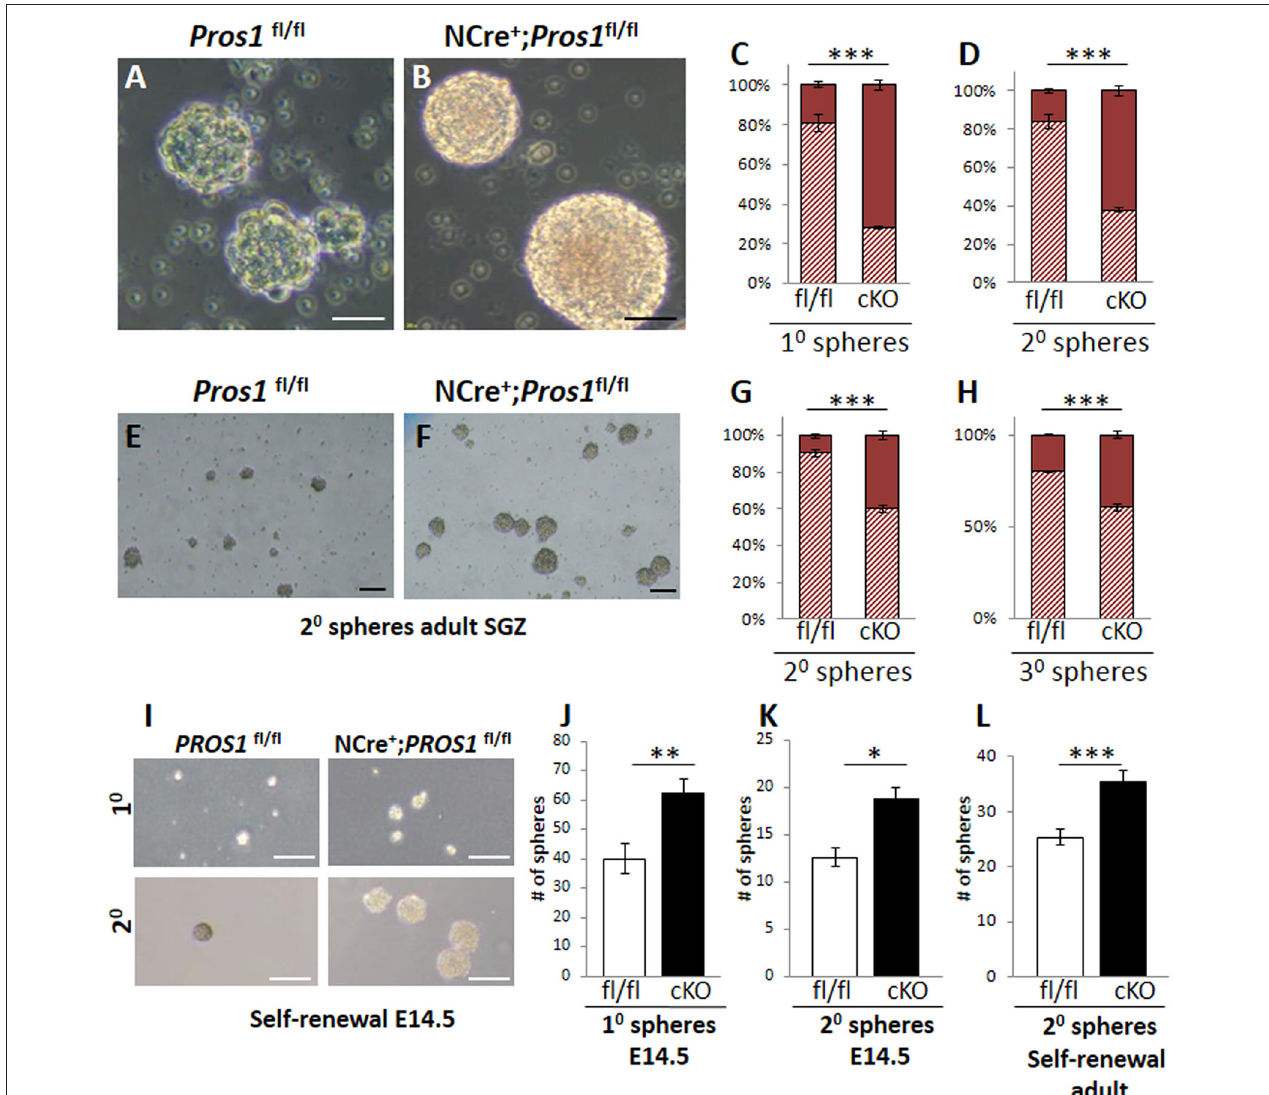
FIGURE 3 | Increased self-renewal following Pros1 -deletion. (A–D) Representative phase-contrast images of neurospheres generated from control (A) and Pros1 -cKO (B) E14.5 NSCs and grown in culture for 4 days. Scale bar = 20 µ M. (C–D) Quantification of primary (C) and secondary (D) neurospheres with diameter smaller or larger than 35 microns (hashed bars and solid bars, respectively) from control and Pros1 -cKO NSCs. Mean values and standard errors were derived from 4 individual experiments. A minimum of three and up to five embryos per genotype were pooled in each experiment. *** P < 0.0001. Statistics are derived from measuring at least 100 neurospheres per experiment. (E–H) Representative phase-contrast images of secondary neurospheres generated from control (E) and Pros1 -cKO (F) adult SGZ NSCs and grown in culture for 14 days. Scale bar = 50 µ M. (G–H) Quantification of secondary (G) and tertiary (H) neurospheres with diameter smaller or larger than 35 microns (hashed bars and solid bars, respectively) from control and Pros1 -cKO adult SGZ NSCs. Pooled cells from 3 to 4 mice per genetic group were used for each experiment. Mean values and standard errors were derived from four individual experiments. *** P < 0.0001. Statistics are derived from measuring at least 50 neurospheres per experiment. (I–L) Self-renewal assays from control and Pros1 -cKO NSCs isolated from E14.5 cortices (I–K) and adult SGZ (L) . (I) Representative images depicting self-renewal capacity of primary (top panels) and secondary (lower panels) neurospheres. Scale bar: 200 µ m. Quantification of the number of primary ( J ; P = 0.002) and secondary ( K ; P = 0.02) neurospheres generated from 2,500 cells, after 10 days in culture. Mean values and standard errors were derived from four individual experiments. A minimum of three and up to five embryos per genotype were pooled in each experiment. (L) Quantification of the number of secondary neurospheres generated from 2,500 adult-SGZ hippocampal NSCs, after 10 days in culture. P = 0.0006. Pooled cells from 3 to 4 mice per genotype were used for each experiment. Mean values and standard errors were derived from four individual experiments. At least 60 E14.5 and 30 adult-derived neurospheres were counted per experiment. *** P < 0.001; ** P < 0.01; * P <